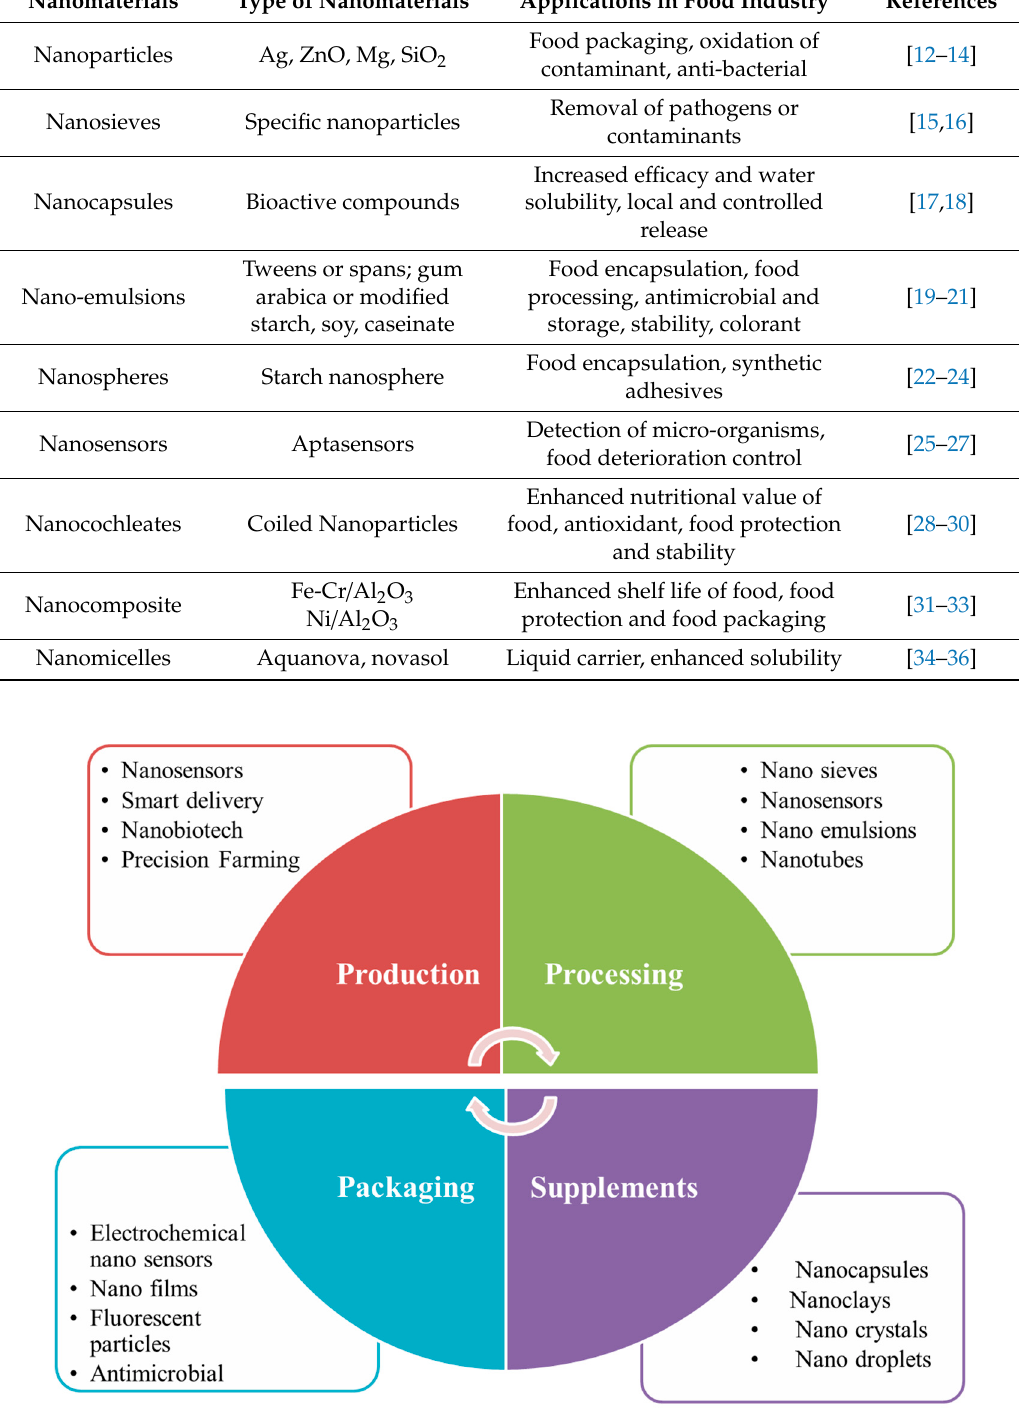
Figure 2. An overview of applications of nanomaterials in the food industry.